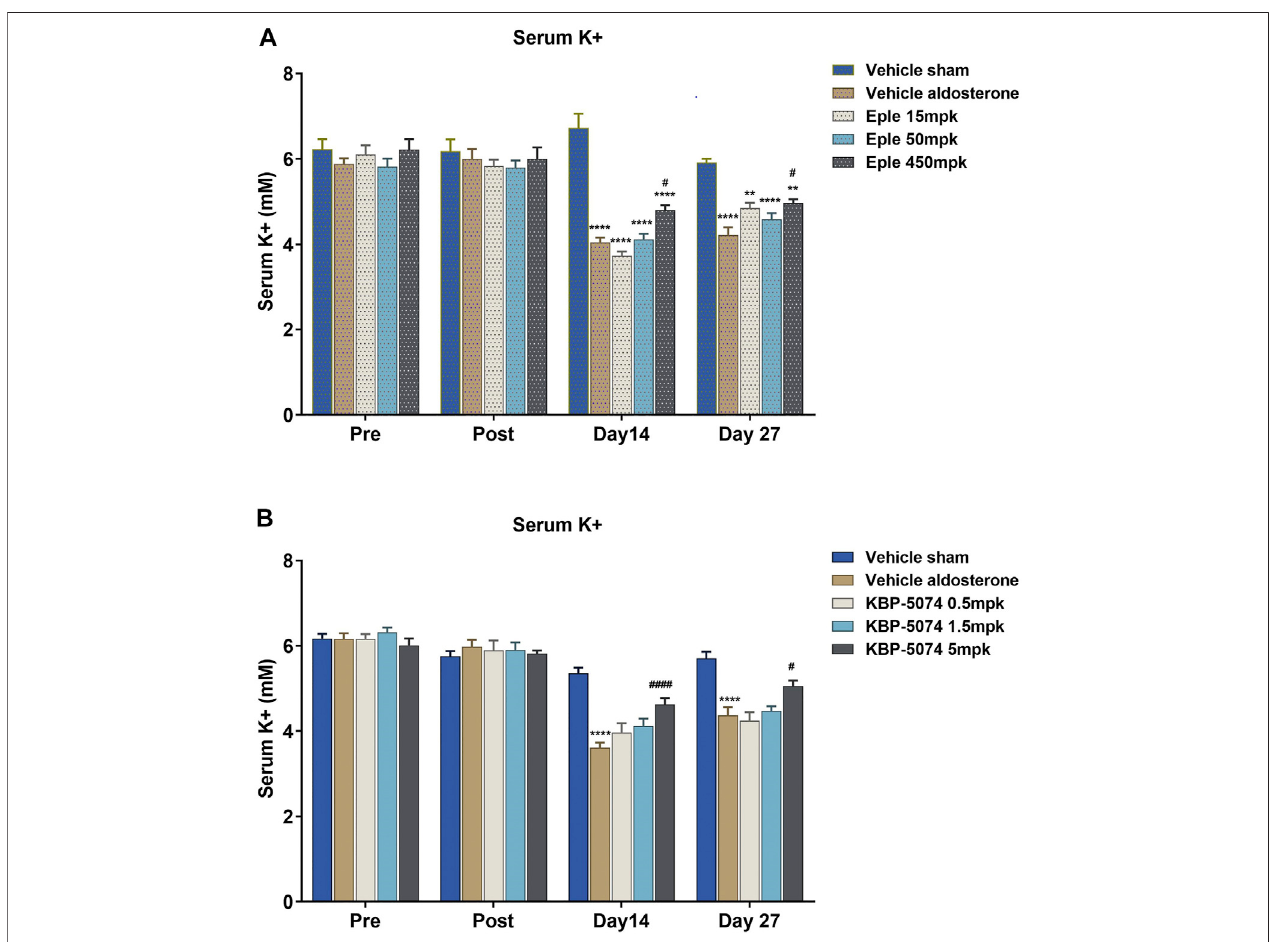
FIGURE 2 | Effect of eplerenone and KBP-5074 on serum K + . (A) Eplerenone: Values are expressed as mean ± SEM. n (cid:2) 11 – 13. ** p < 0.01, **** p < 0.0001 vs. Vehicle Sham group, # p < 0.05 vs. Vehicle Aldosterone model group followed by two-way ANOVA Tukey ’ s multiple comparisons test. (B) KBP-5074: Values are expressed as mean ± SEM. n (cid:2) 11 – 13. **** p < 0.0001 vs. Vehicle Sham group, # p < 0.05, #### p < 0.0001 vs. Vehicle Aldosterone group followed by two-way ANOVA Tukey ’ s multiple comparisons test. Eple, eplerenone; SEM, standard error of the mean.